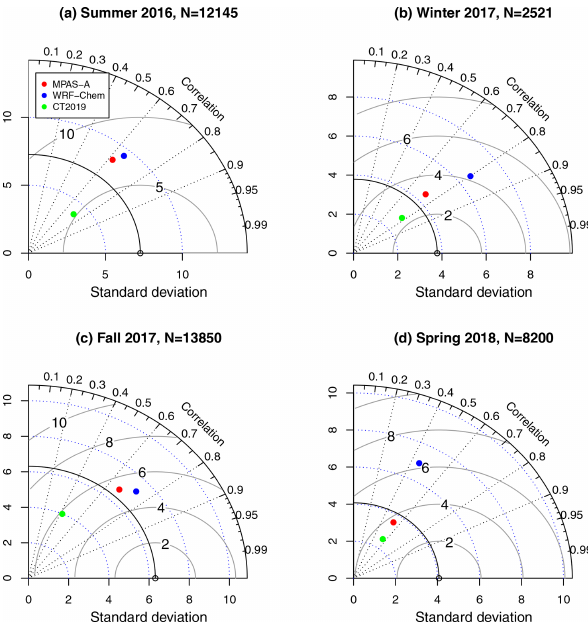
Figure 14. Taylor diagram for model evaluation using ACT air- borne measurements from front-crossing flights. For each of the four ACT campaign seasons, observation–model data pairs from all front-crossing flights are combined. N is the number of data pairs used for creating the